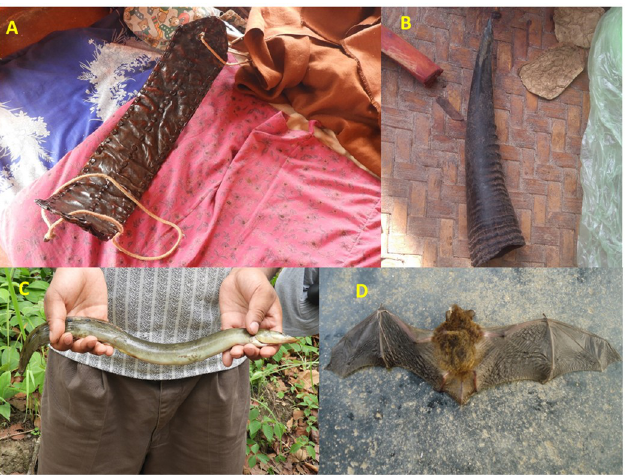
Fig 6. Parts of animals used by local ethnic groups for the treatment of different diseases: A- Belt made by the skin of Monitor lizard (belt made by dry skin is used during backbone pain) B- Horn of Himalayan goral (The horn of the goral is rubbed and made a fine paste and used in the navel region for curing the stomach pain) C- Gangetic mudeel (Boiled meat is prescribed to eat to get relief from muscular pain; raw blood is consumed for the treatment of anemia). D- Bat (The cooked meat of bat is good for asthma, tuberculosis).